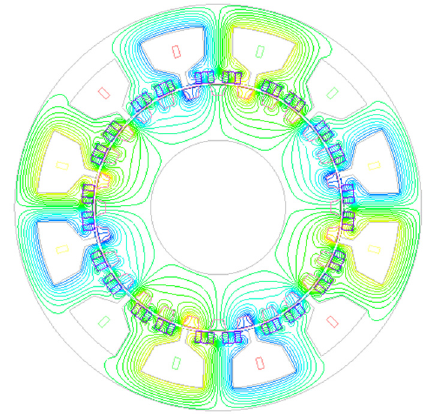
Figure 13. Field distributions at no-load.